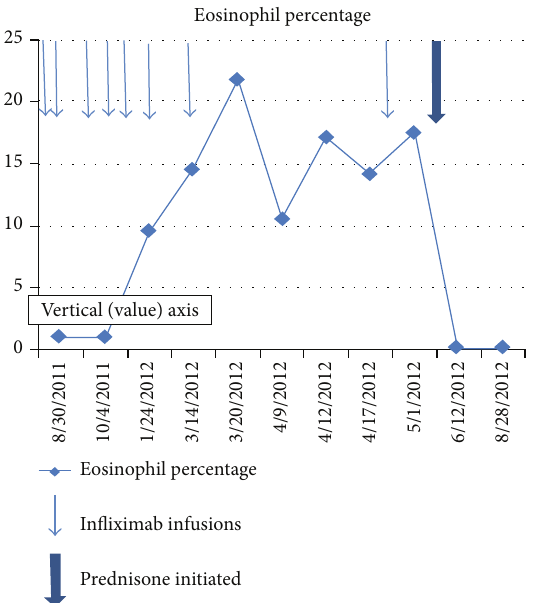
Figure 2: Peripheral eosinophil counts. This graph shows the eosinophil percentage as a function of time. The thin arrows denote the dates of infliximab infusions. The thick arrow shows the initiation of steroid